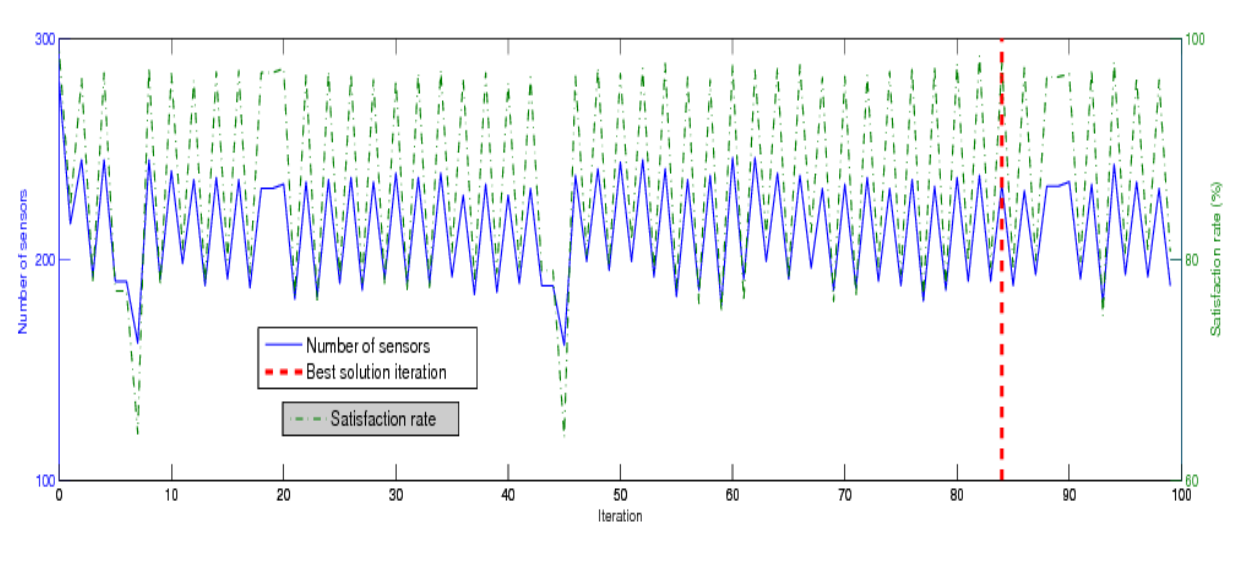
Figure 5. Tabu Search: evolution of